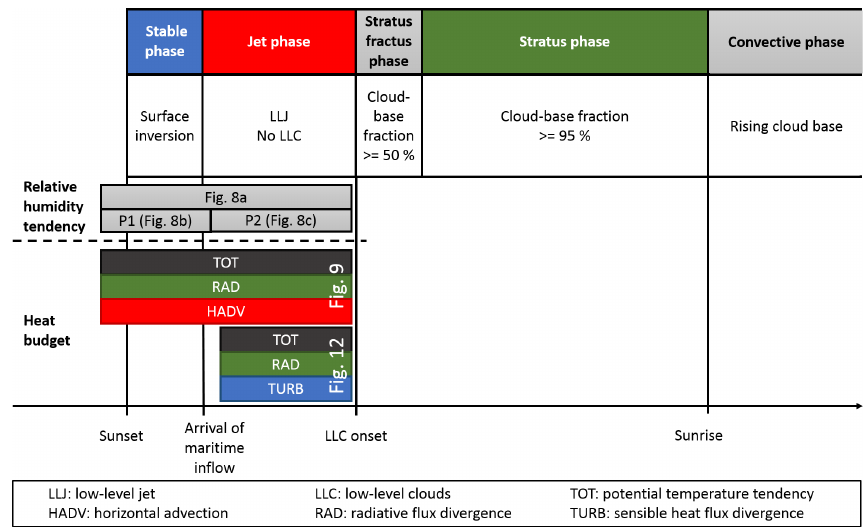
Figure 2. Schematic overview of the different phases including their main characteristics. The width of the boxes is a rough estimate of the mean duration of the individual phases. Note that the stratus fractus phase does not occur during all nights. The different time periods considered for the estimation of the relative humidity changes and the heat budget terms are